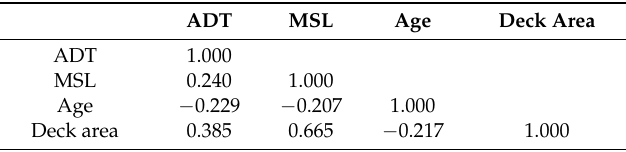
Table 1. Correlation between covariates.